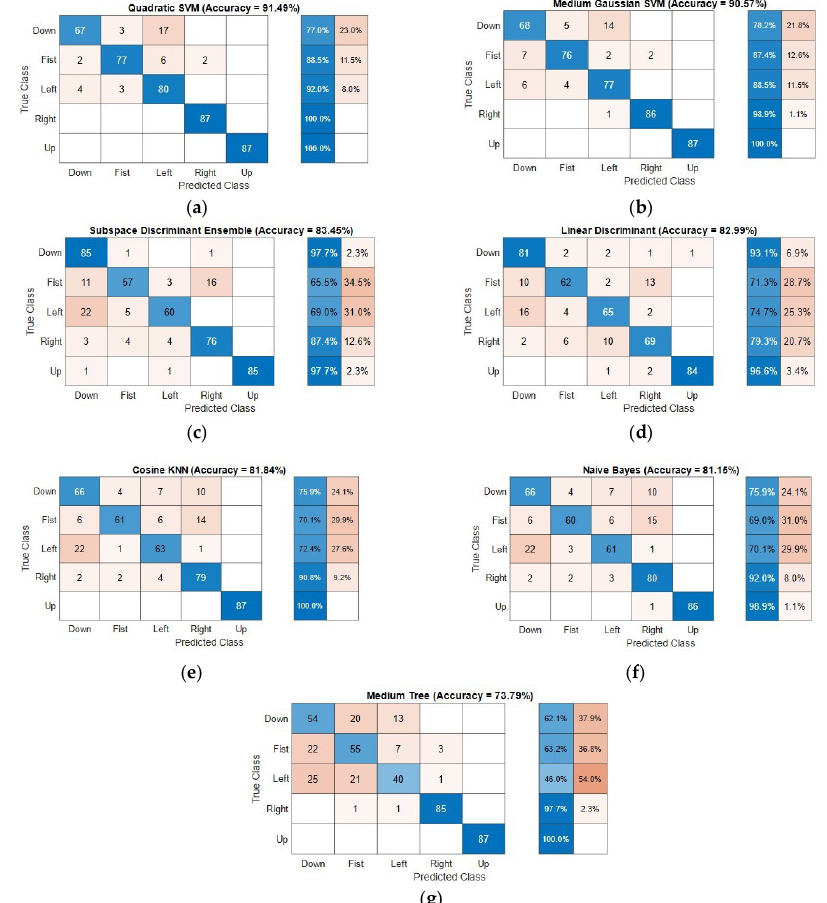
Figure 5. Confusion matrices showing the true positives rates and average accuracy (percentage in brackets) for the gesture classification problem based on various algorithms: ( a ) quadratic support vector machine (SVM) (91.49%); ( b ) medium Gaussian SVM (90.57%); ( c ) subspace discriminant ensemble (83.45%); ( d ) linear discriminant (82.99%); ( e ) cosine k-nearest neighbor (kNN) (81.84%); ( f ) naïve Bayes (81.15%), and ( g ) medium tree (73.79%).